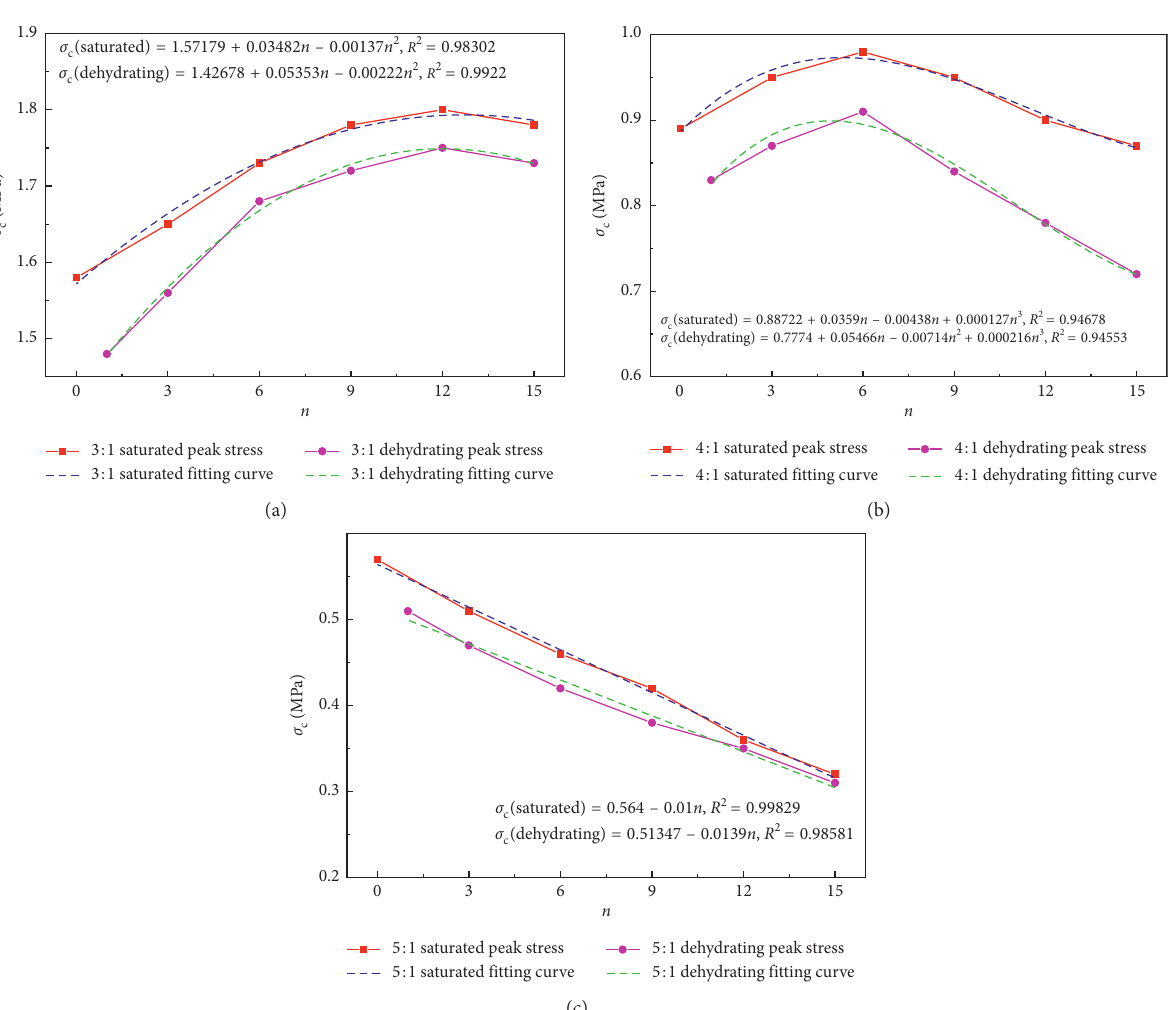
Figure 5: Relationship between peak stress and dry-wet cycles: (a) 3 :1, (b) 4:1, and (c) 5